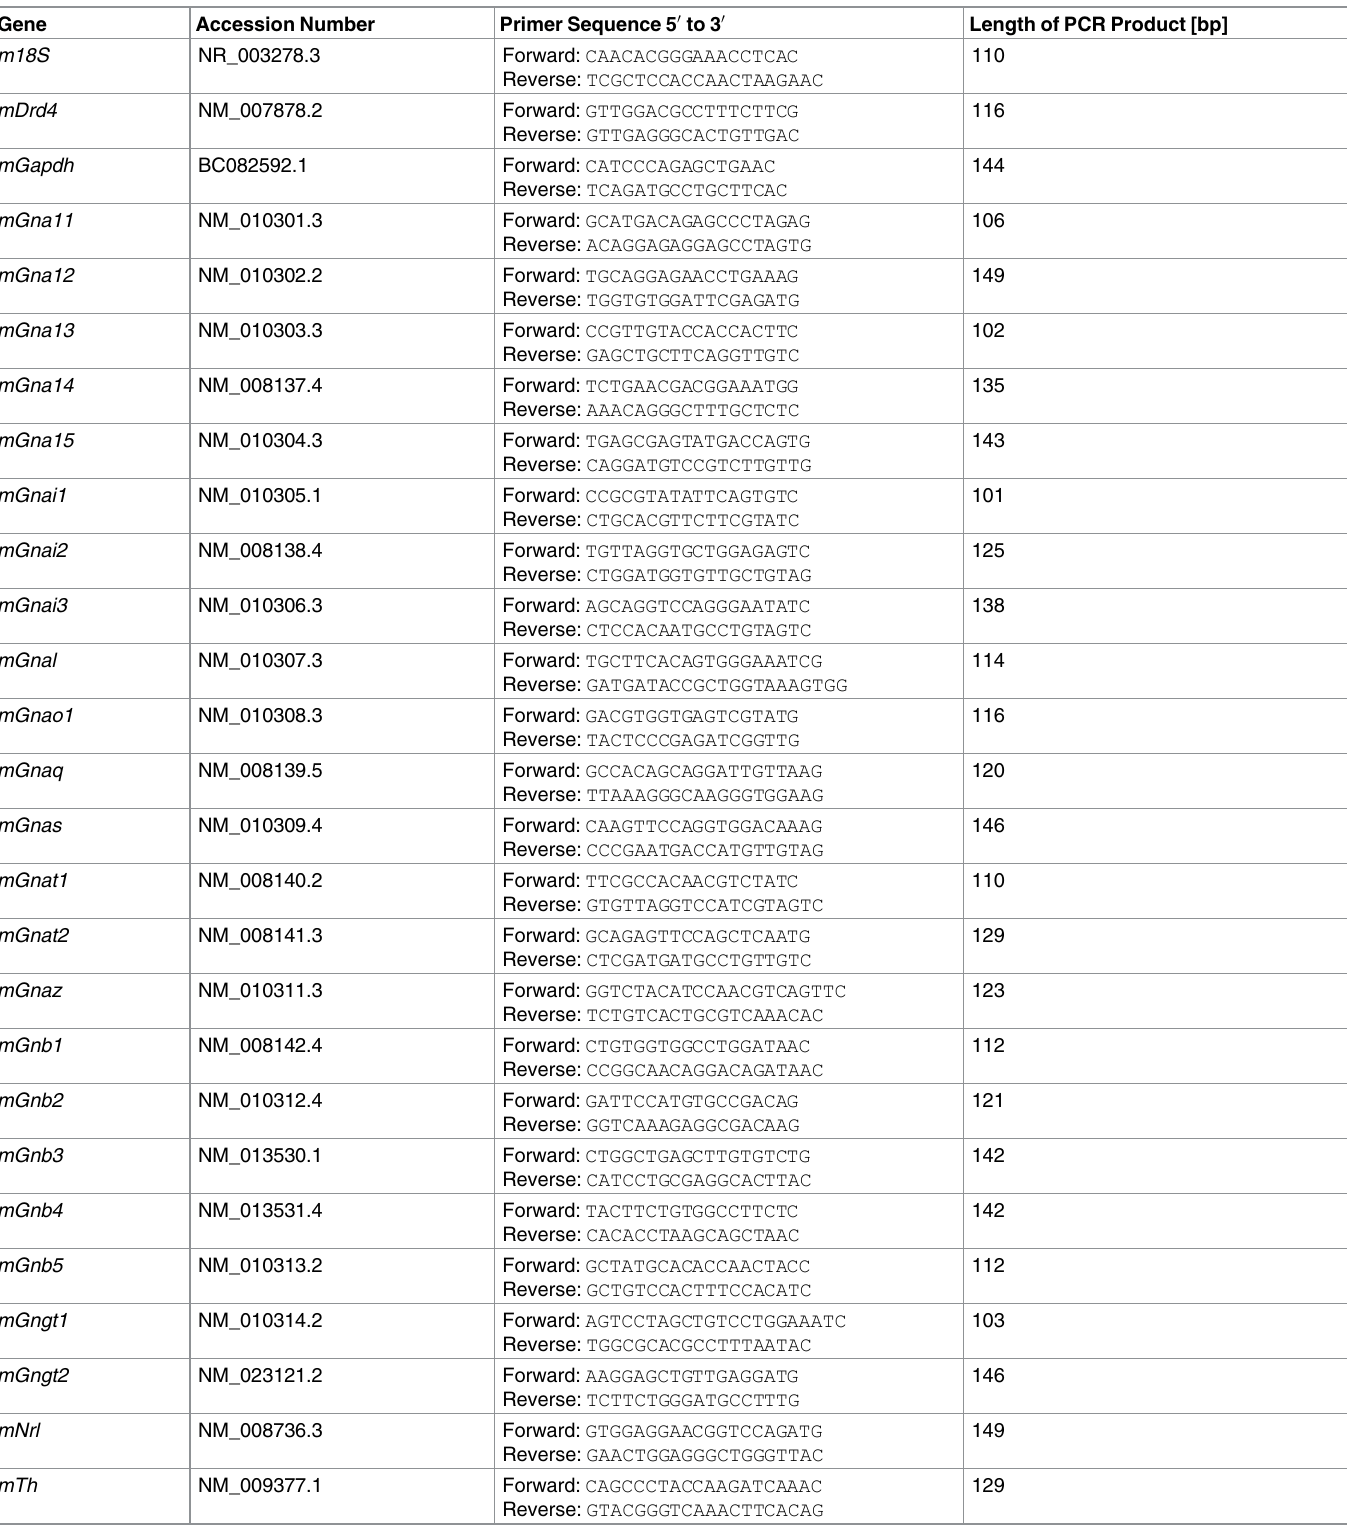
Table 1. Primer sequences used for